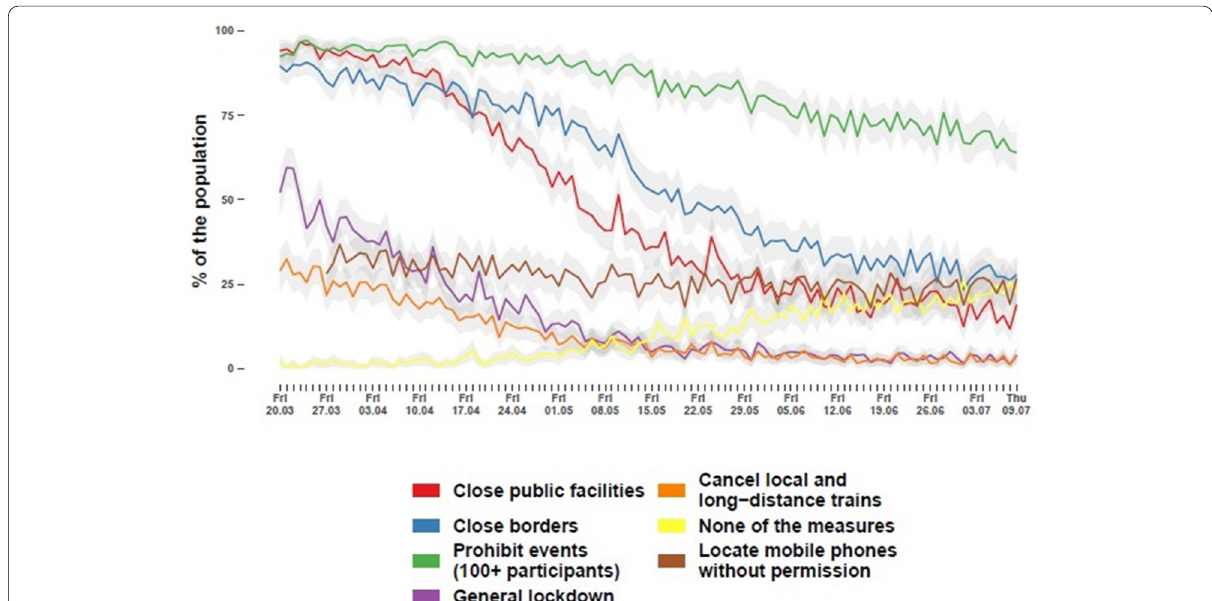
Fig. 3 Proportion of the population that endorses certain measures on the day of the survey. Light gray areas represent 95% confidence